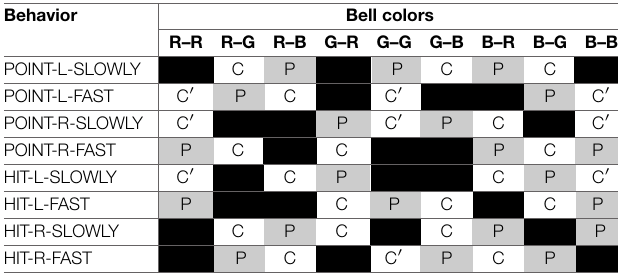
TABLE 2 | Episodes included in dataset 3 (48/144)